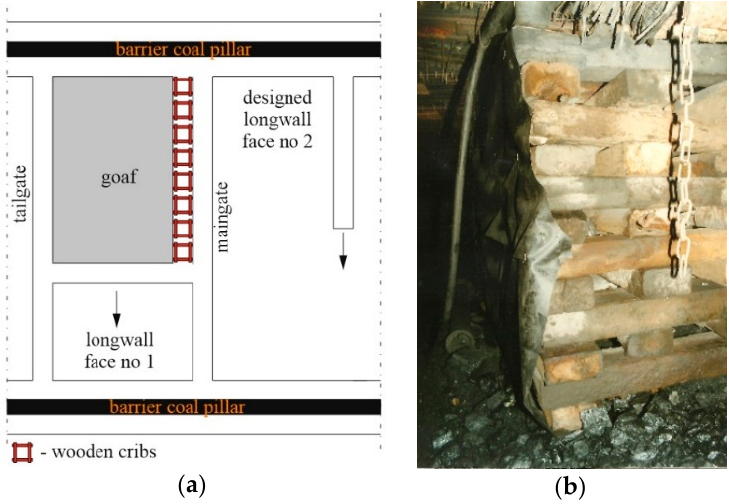
Figure 1. Application of wooden cribs to maintain the roadway for the next longwall: ( a ) Arrangement of wooden cribs in a maingate; ( b ) General view of the wooden crib.